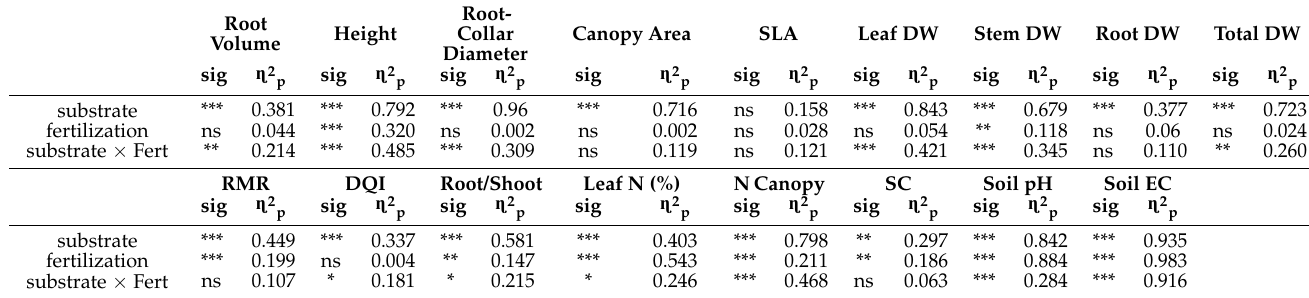
ɳ 2 p) of each factor (substrate and fertilizer Table 2. Significance (sig) and size effect determined as partial eta-squared ( management) and their interaction of the different variables measured. * p < 0.05; ** p < 0.01; *** p < 0.001; ns, non-significant. SLA, specific leaf area; DW, dry weight; RMR, root mass ratio; DQI, Dickson quality index; SC, stomatal conductance; EC, soil electrical